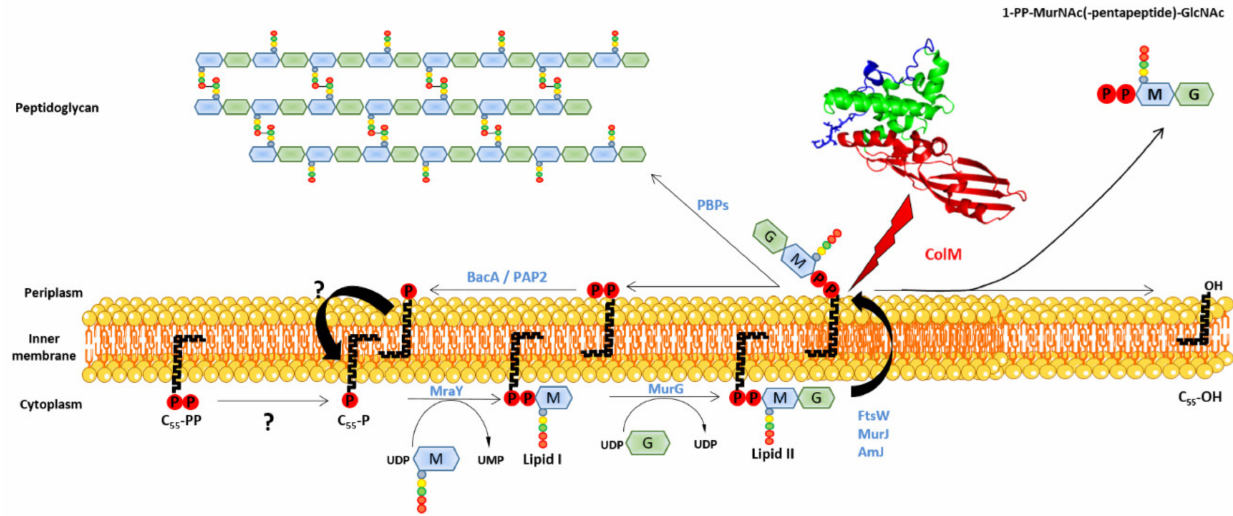
Figure 5. Peptidoglycan biosynthesis pathway and mode of action of ColM. ColM hydrolyzes the phosphodiester bond of lipid II (red lightning), thereby leading to the formation of two products: undecaprenol (C 55 -OH) and 1-PP-MurNAc(- pentapeptide)-GlcNAc. ColM is represented in